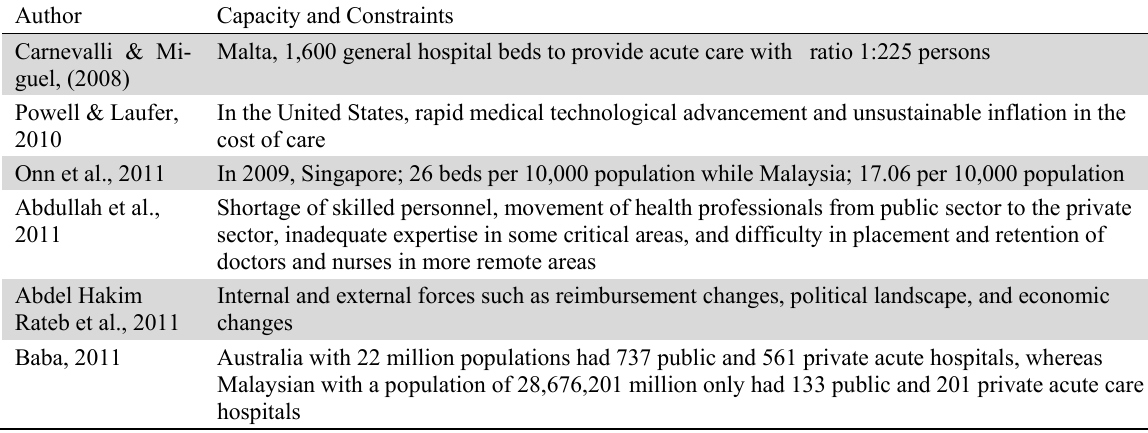
Summary of healthcare capacity and